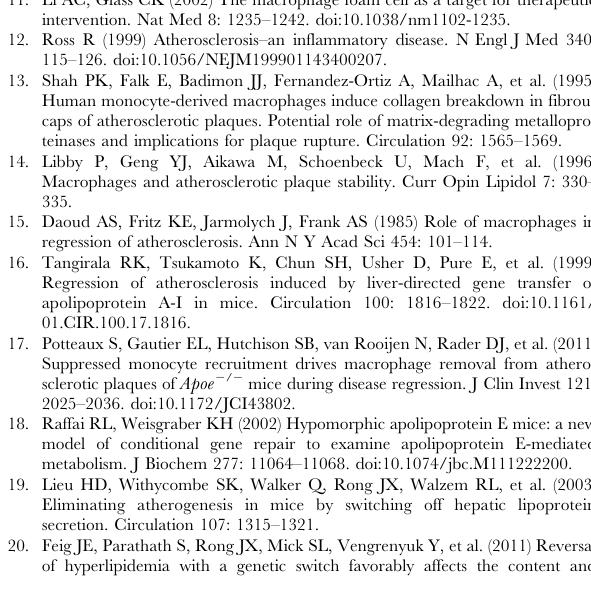
Table S11 Results of microRNA target sequence enrichment analysis for sets of genes that are differentially expressed in plaque CD68 + cells from Mttp -inactivated vs. vehicle-treated Reversa mice. Columns are as follows: (A) MicroRNA name; (B) Total number of target sequences among all mouse genes; (C) Expected number of target sequences for the indicated gene set (upregulated or downregulated genes); (D) Observed number of target sequences for the indicated gene set; (E) P value from the hypergeometric test; (F) ratio of observed to expected count. Table S12 Results of pathway enrichment analysis of genes possessing target sequences for microRNAs listed in Figure 4A, derived from transcriptome profiling of plaque CD68 + cells from Reversa mice in plaque regression. Columns are as follows: (A) Pathway/function name; (B) Pathway ID; (C) Number of genes in the pathway that have a target sequence for one of the microRNAs in Figure S4A; (D) P value for enrichment test; (E) Official gene symbols; (F) Ensembl Gene IDs. Table S13 qPCR primers that were used in this study. Columns are: (A) Official gene symbol; (B) Taqman assay